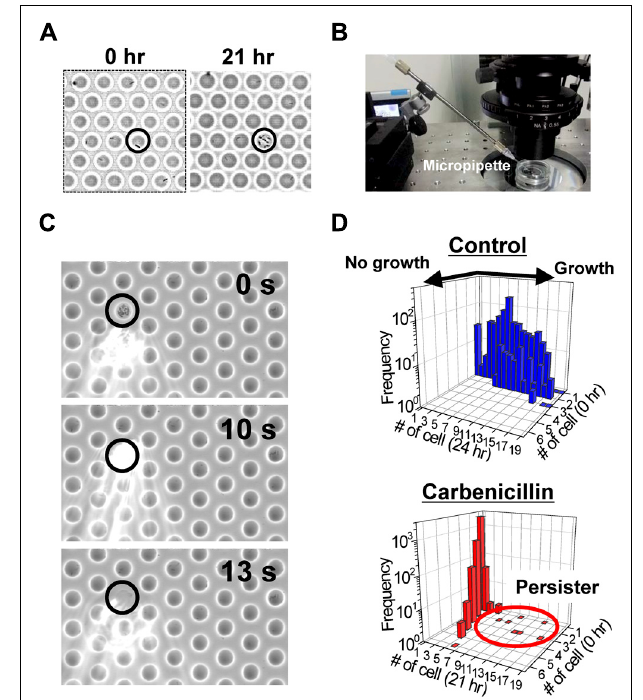
FIGURE 3 | Detection of the persisters in the femtoliter droplet array. (A) Images of P. aeruginosa PAO1 persisters (indicated by circle) after 0 h (left) and 21 h (right) of culture in the femtoliter droplet array. (B) Image of the micropipette used for droplet collection. (C) Sequential images of droplet collection. (D) Distribution of the number of cells in each droplet before and after overnight culture.Top, control cells without carbenicillin treatment. Bottom, carbenicillin-treated